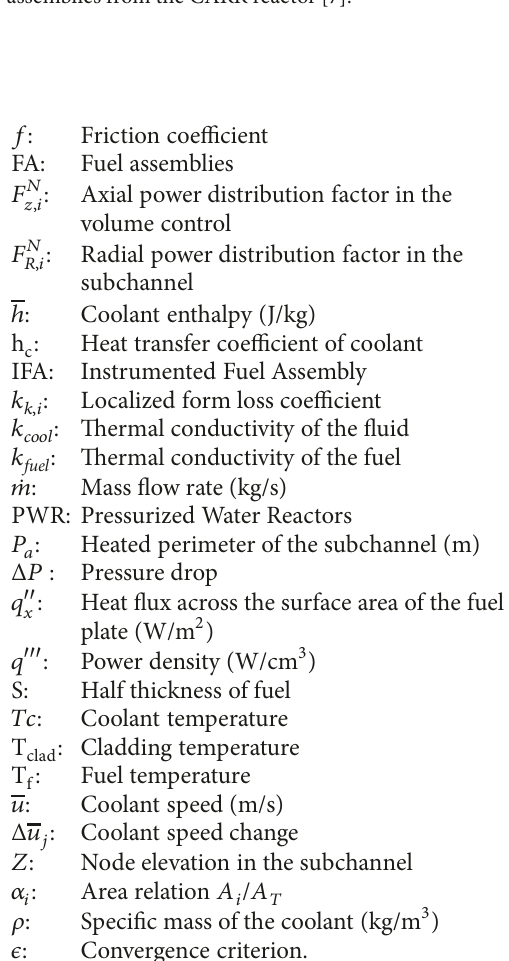
Figure 15: Axial power factors for the standard and open fuel assemblies from the CARR reactor